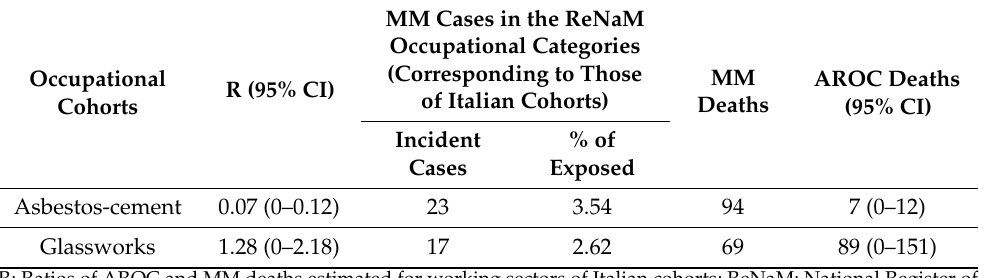
Table 3. Asbestos-related ovarian cancer (AROC) and malignant mesothelioma (MM) deaths esti- mated in occupational categories. Period: